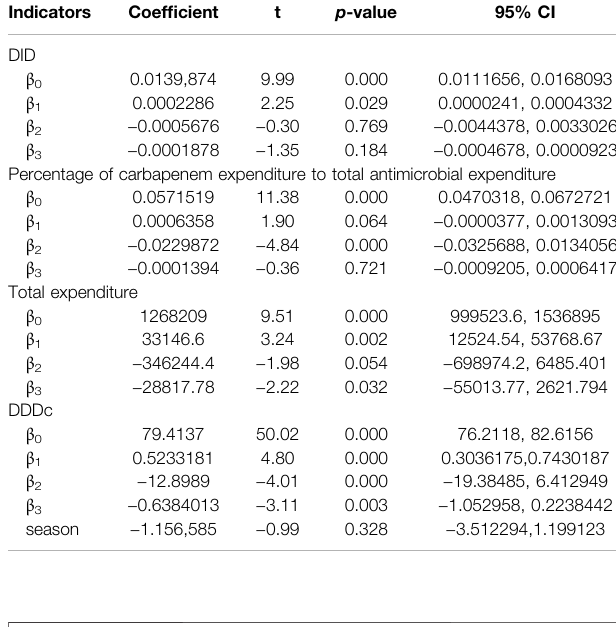
TABLE2| Theimpactoftheimplementationoftheexpertconsensusontheuseof carbapenems in Shaanxi.